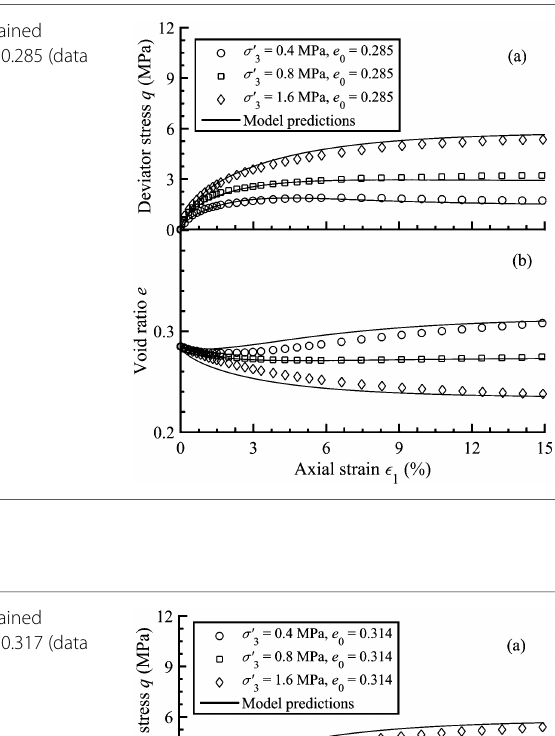
Figure 10 Model predictions of the drained behaviour of Tacheng rockfill with e 0 = 0.285 (data from Xiao et al. [12])